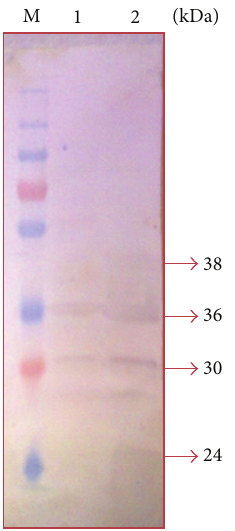
Figure 4: Immunodominant outer membrane proteins of Pas- teurella multocida B:2 in field sera. Lane M: protein marker (250– 10 kDa). Lane 1: immunodominant proteins in iron-limited condi- tion. Lane 2: immunodominant protein in normal condition.